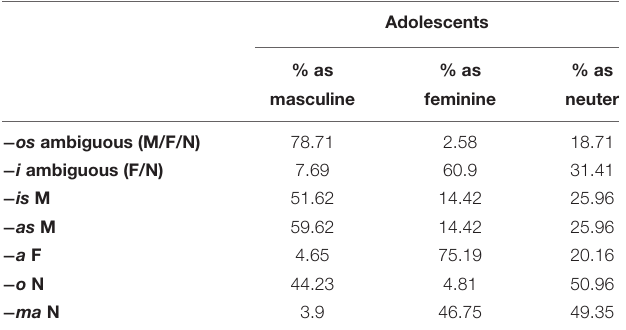
TABLE 10 | Distribution of responses for novel nouns by the older group